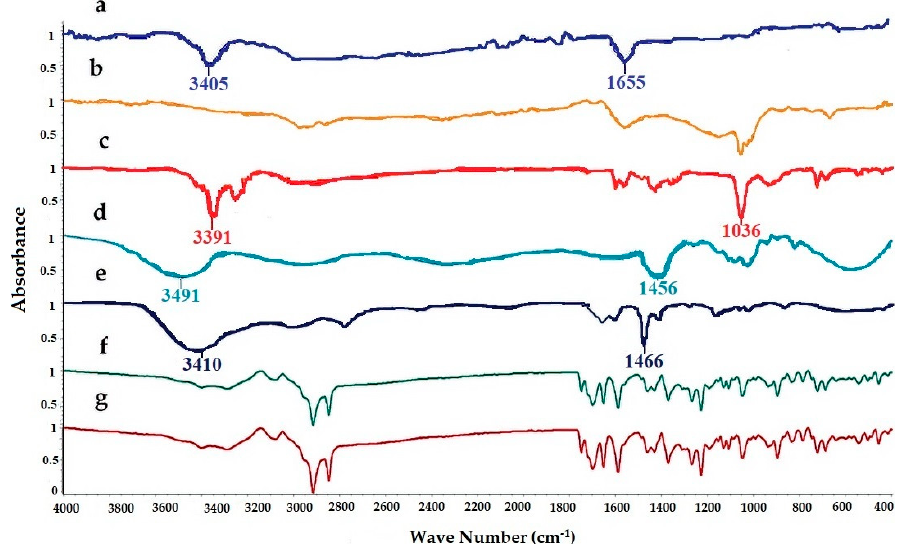
Figure 2. FTIR spectra of: ( a ) luteolin (LUT), ( b ) SL, ( c ) ethanol (EtOH), ( d ) propylene glycol (PG), ( e ) cholesterol, ( f ) physical mixture, and ( g ) LUT-ENPs (F8).